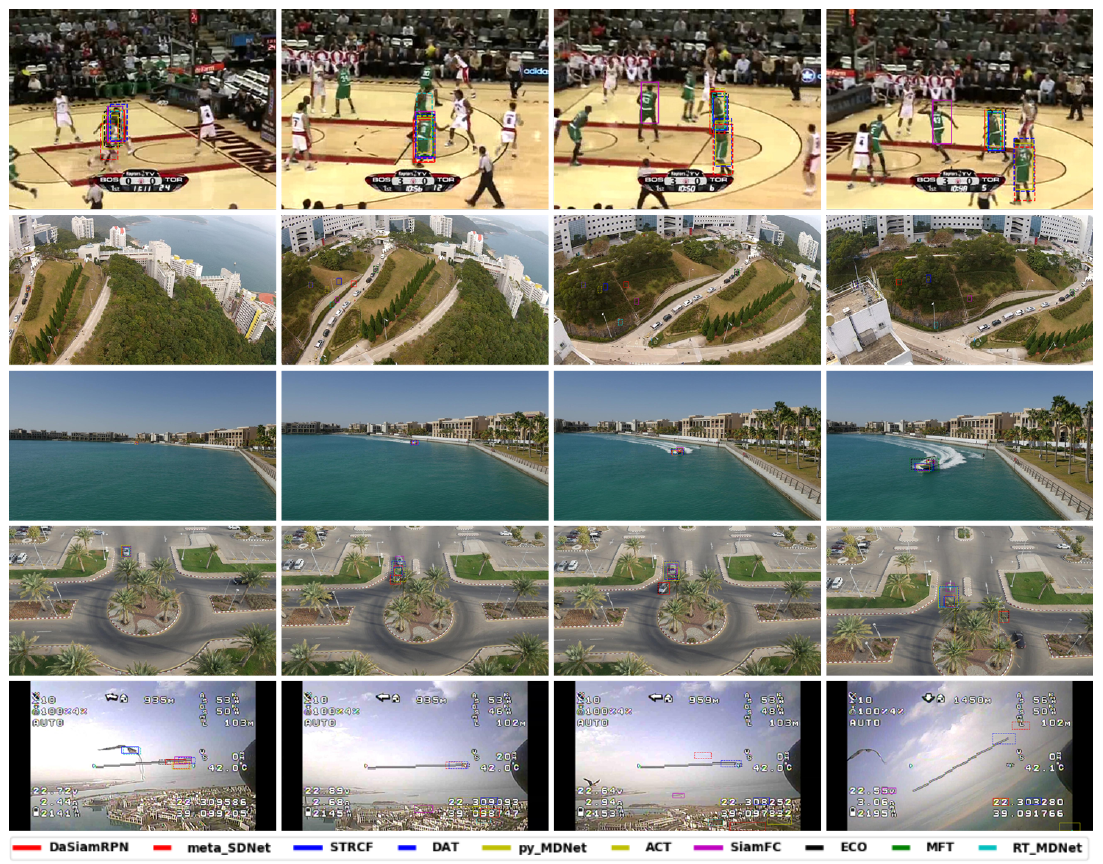
Figure 9. Tracking visualization on different sequences (top to bottom): Basketball (OTB), Car2 (DTB70),